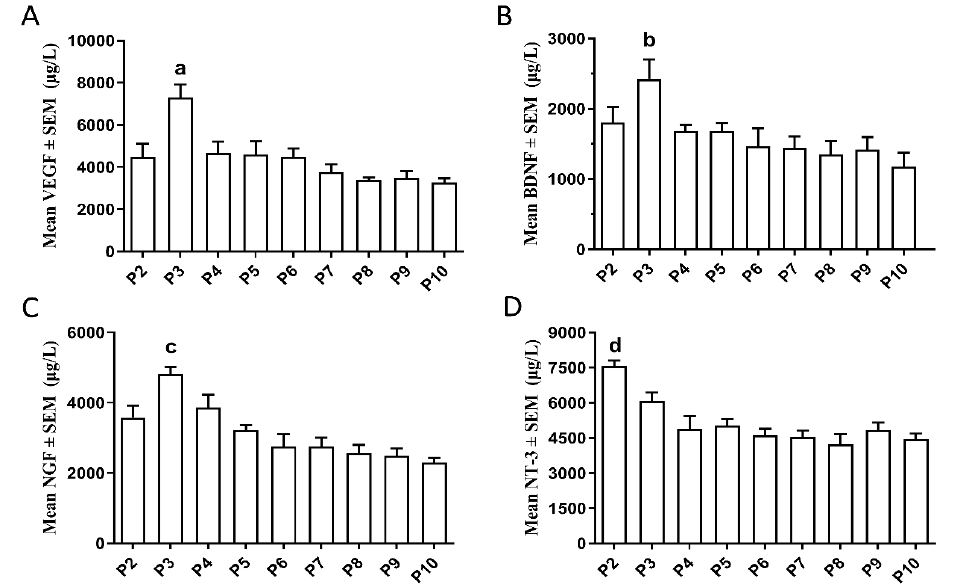
Fig. 4. Secretion of vascular endothelial growth factor, brain-derived nerve growth factor, nerve growth factor, and neurotrophin-3 from human dental pulp stem cells at different